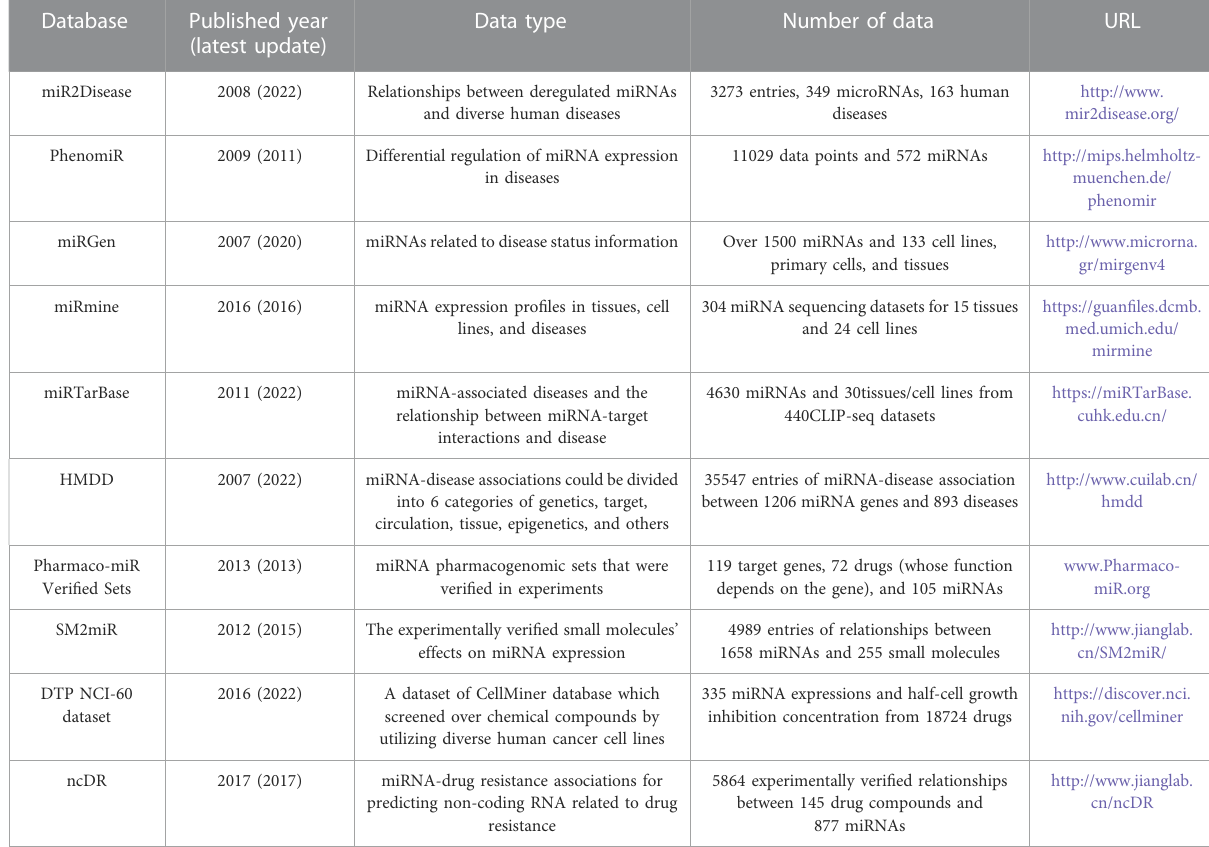
TABLE 1 Main databases for accelerating miRNA therapy based on machine